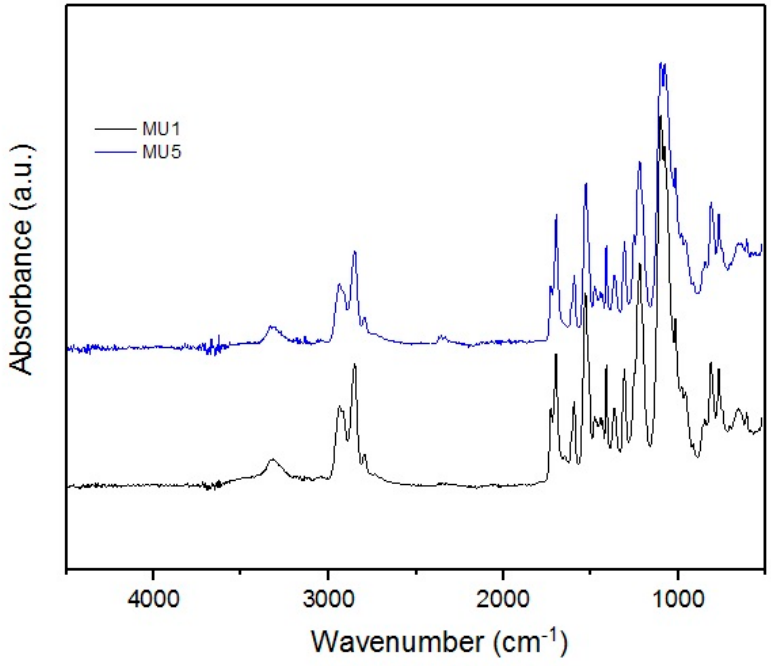
Figure 3. FT-IR spectra of MU1 and MU5 composites.